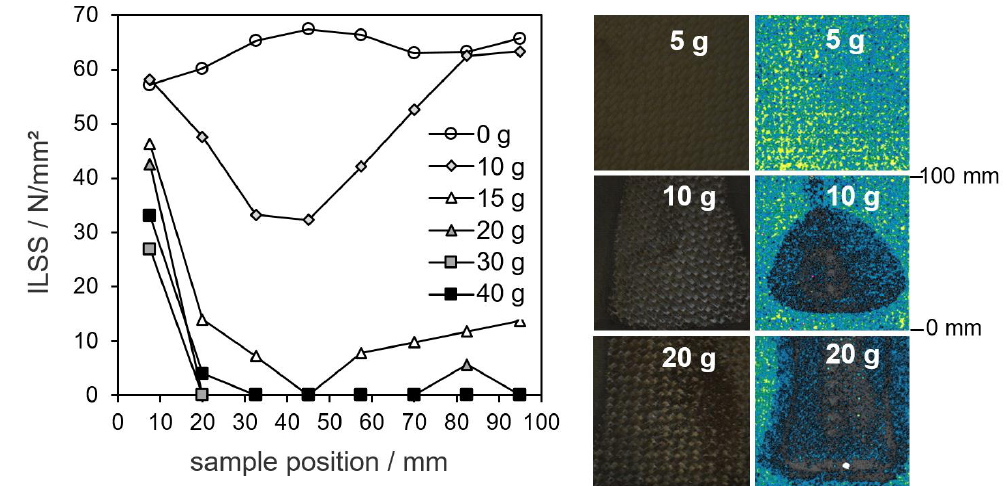
Figure 13. Representative distribution of interlaminar shear (ILS) strength and corresponding ultrasonic scans after the impact of various amounts of fire accelerants on vertically aligned 2 mm thick 8552/IM7 samples.